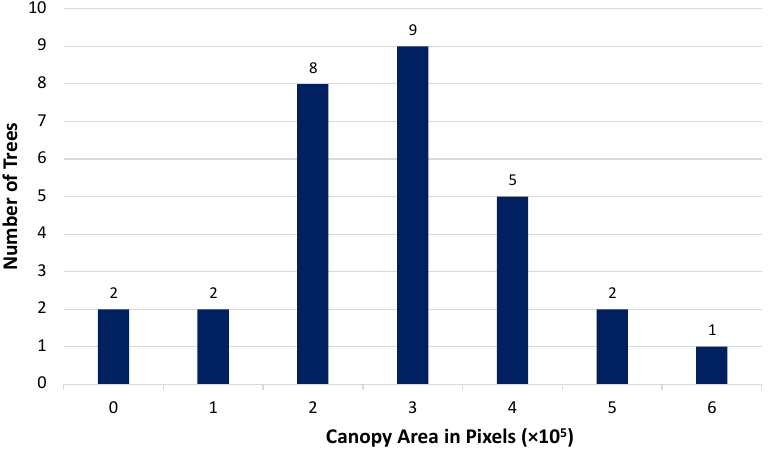
Figure 6. Distribution of the identified trees.